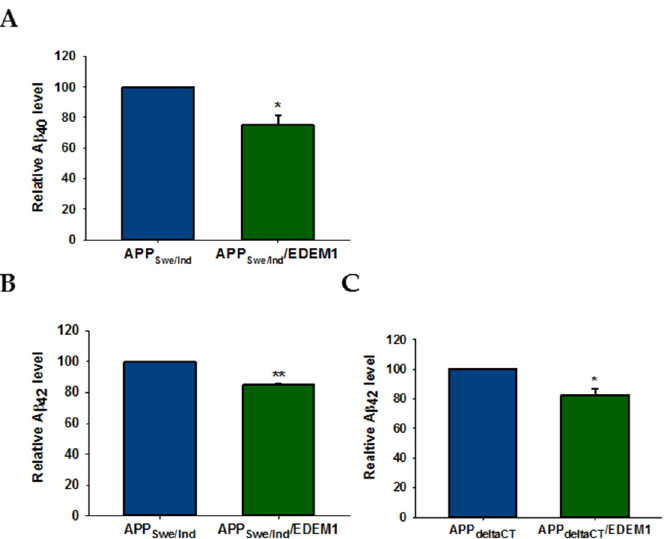
Figure 10. Amount of A β 40 and A β 42 is decreased in EDEM1-transfected HEK293 cells. ELISA anal- ysis of ( A ) A β 40 and ( B,C ) A β 42 levels in conditioned media from ( A,B ) APP Swe/Ind and ( C ) APP deltaCT cells with or without EDEM1 cotransfection. Values obtained for media of cells without EDEM1 overexpression are indicated as 1. Values representing EDEM1-transfected cells are plotted relative to 1. The values are expressed as mean ± SD, n = 3,* p ˂ 0.05, ** p ˂ 0.01, Student’s t test.